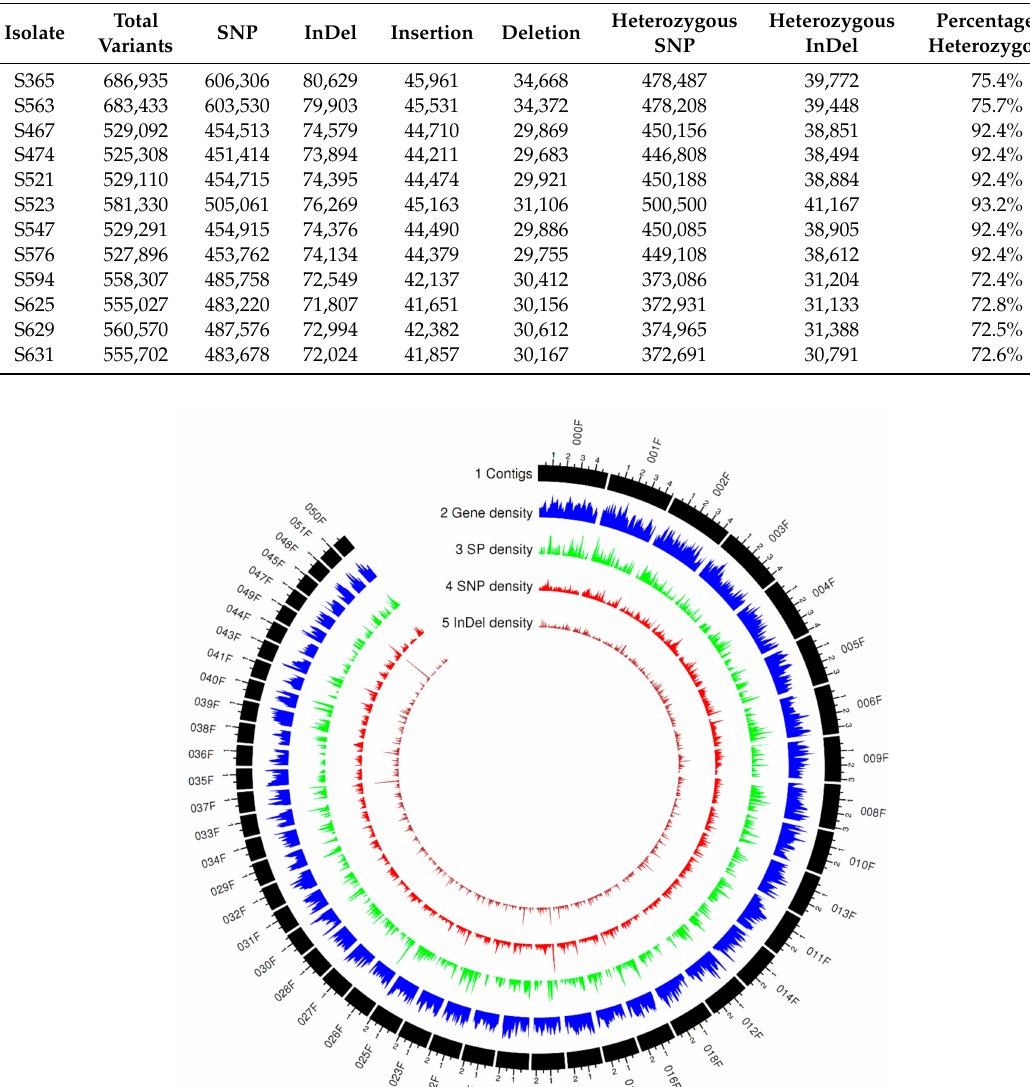
Table 2. Summary of small genomic variants in the 12 Pt isolates.